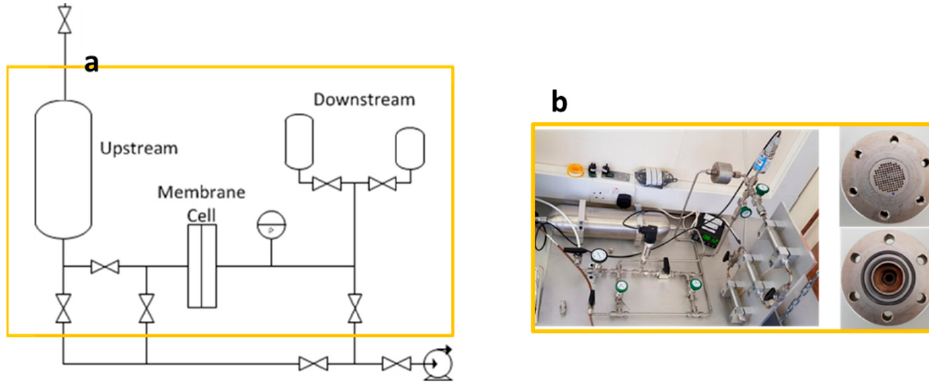
Figure 3. Permeation rig: ( a ) schematic; ( b ) rig with the cell. Permeability was obtained from the evolution of pressure on the downstream side.